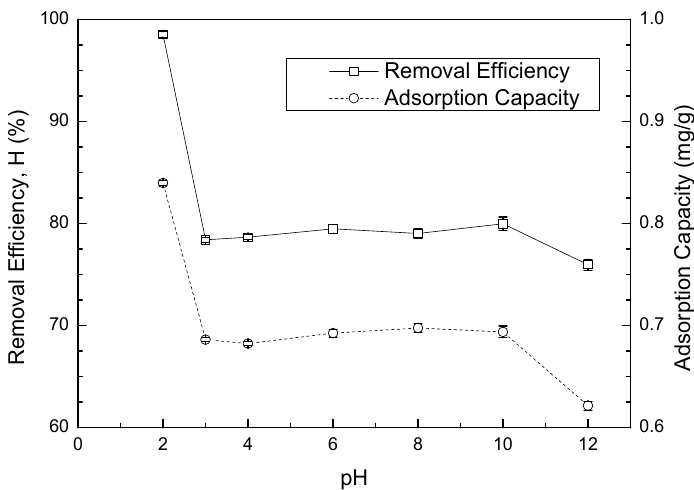
Figure 6. Impact of pH on adsorption of RB5 on UBC.